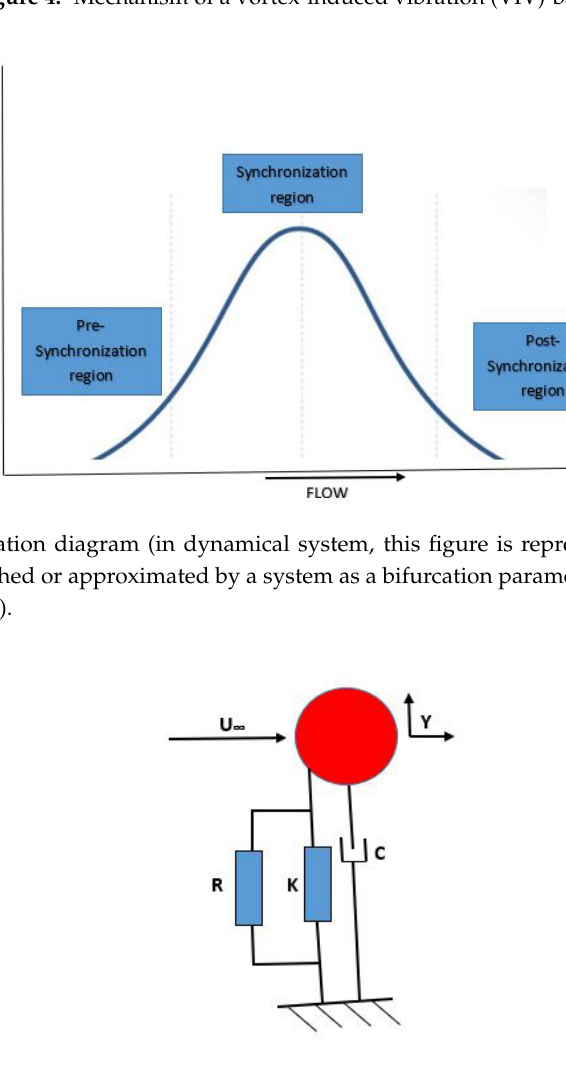
Figure 4. Mechanism of a vortex-induced vibration (VIV)-based PEH.